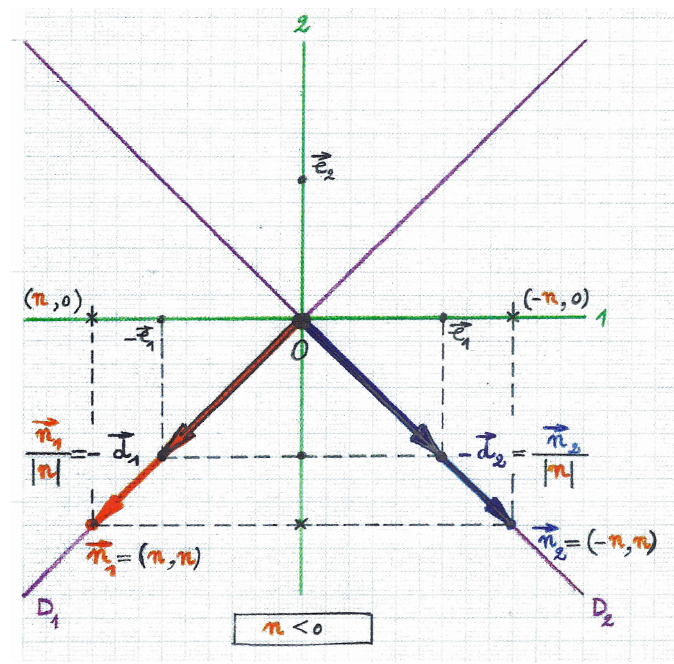
Figure 6. The two other normalised null